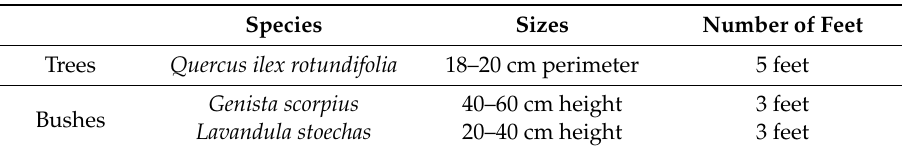
Table 12. Species for perimetral